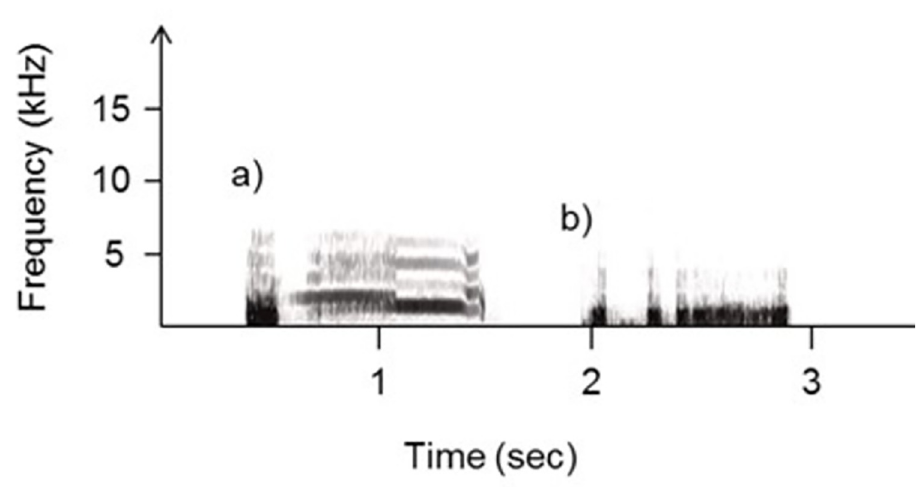
Fig 1. Spectrograms of sound treatments played to chickens. a) alarm call (test playback) and b) contentment call (control playback).